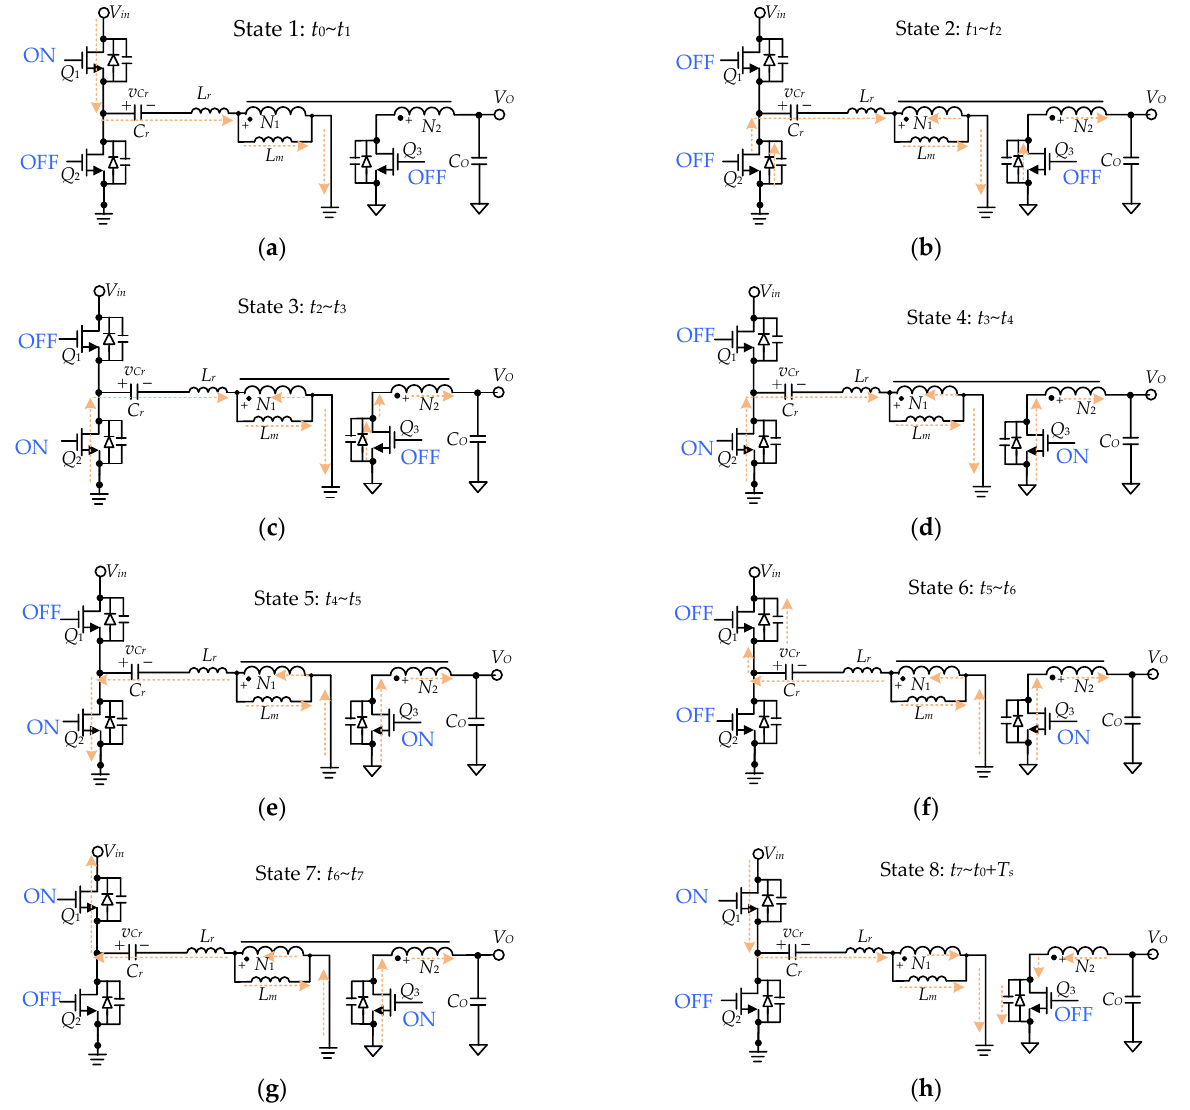
Figure 4. Operation states of the proposed circuit: ( a ) state 1; ( b ) state 2; ( c ) state 3; ( d ) state 4; ( e ) state 5; ( f ) state 6; ( g ) state 7; and ( h ) state